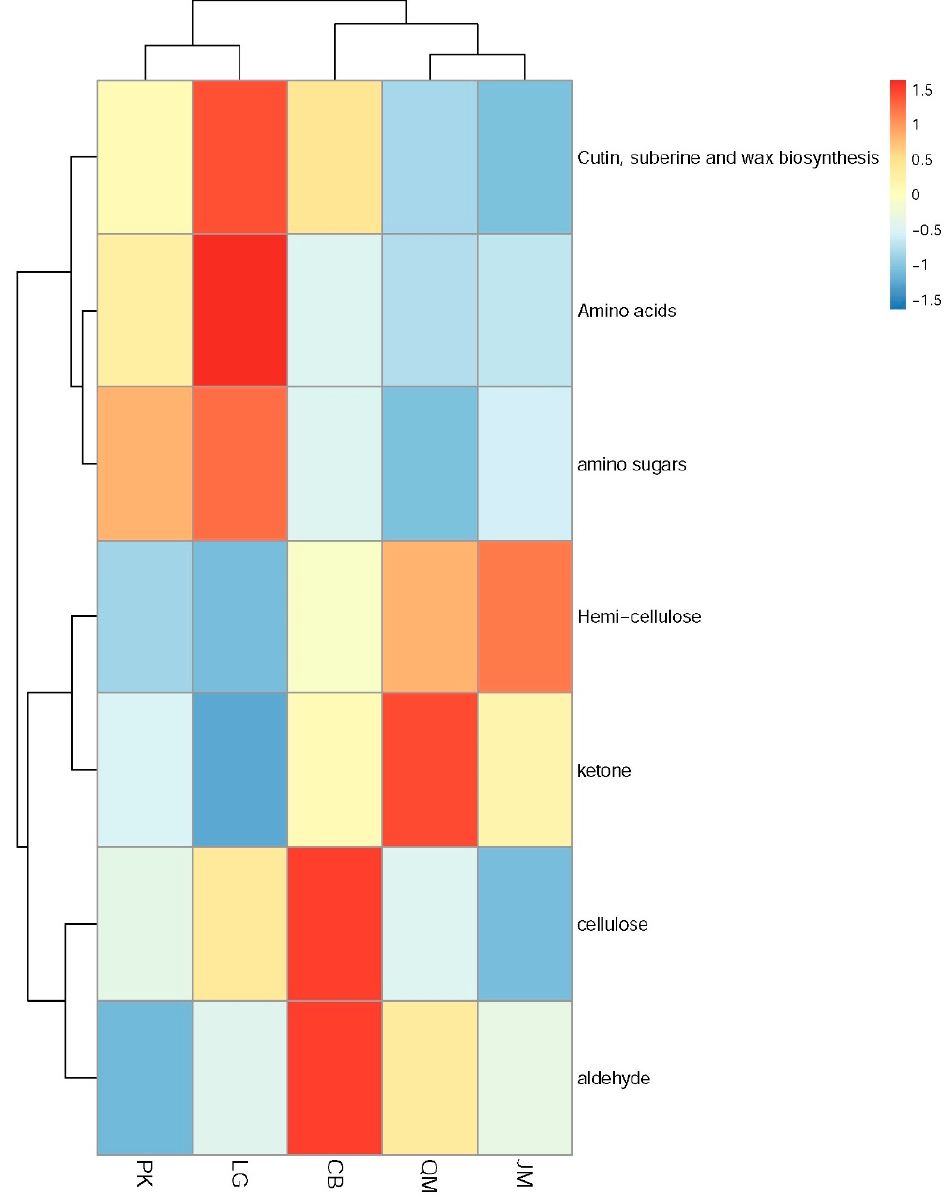
Figure 8. Heatmap analysis based on the relative abundance of corresponding macro-molecular compounds metabolism of different organic carbon functional group. LG: Larix gmelinii ; PK: Pinus koraiensis ; CB: Conifer-broadleaf forest; JM: Juglans mandshurica ; QM: Quercus mongolica .